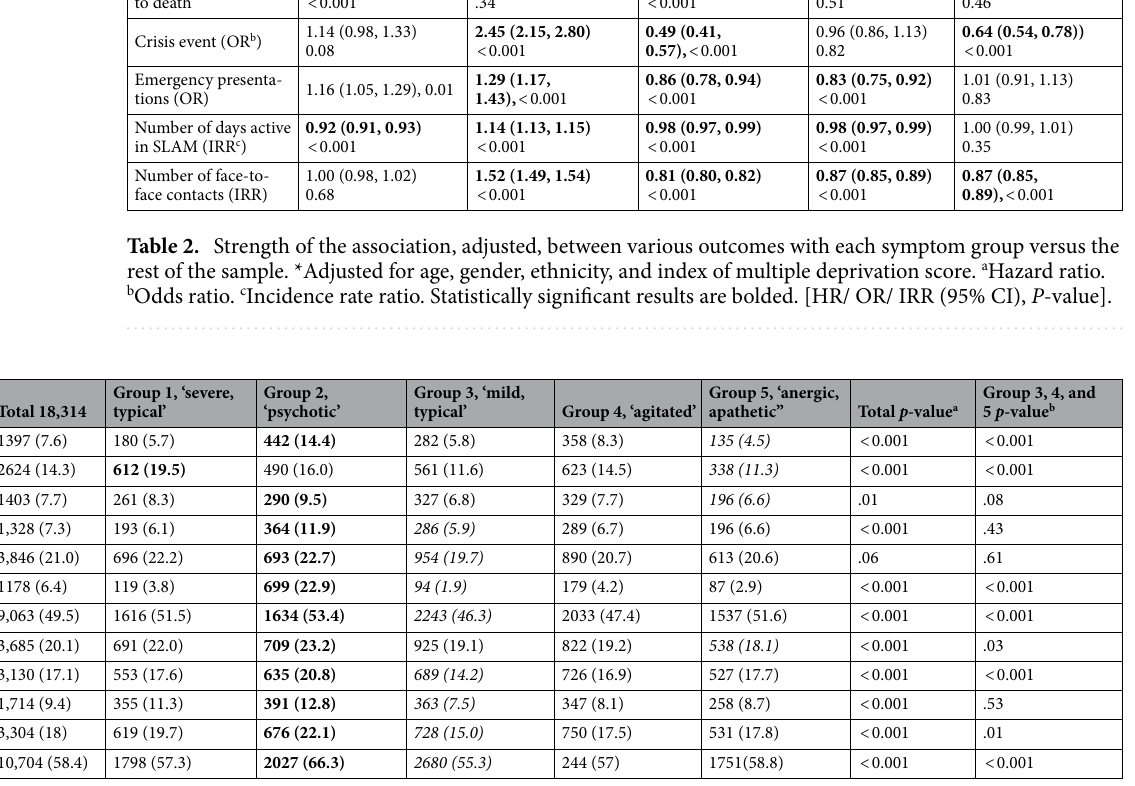
Severe, typical Psychotic Mild, typical Agitated Anergic, apathetic